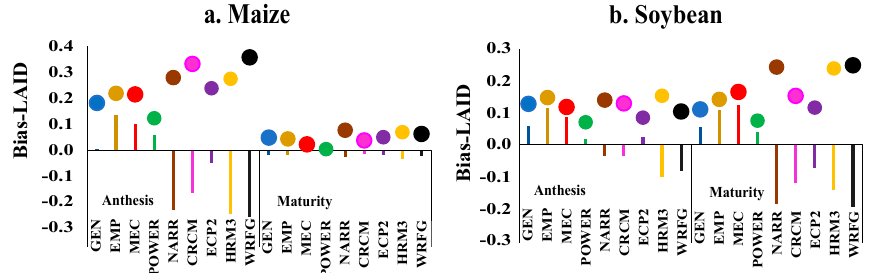
Figure 6. Root mean squared error (RMSE, colored circles) and mean error (ME, colored bars) of daily leaf area index (LAID) for the different sources of estimated solar radiation at the start date of planting, emergence, anthesis, and maturity for maize ( a ) and soybean ( b ). See Figure 2 for definition of abbreviations.